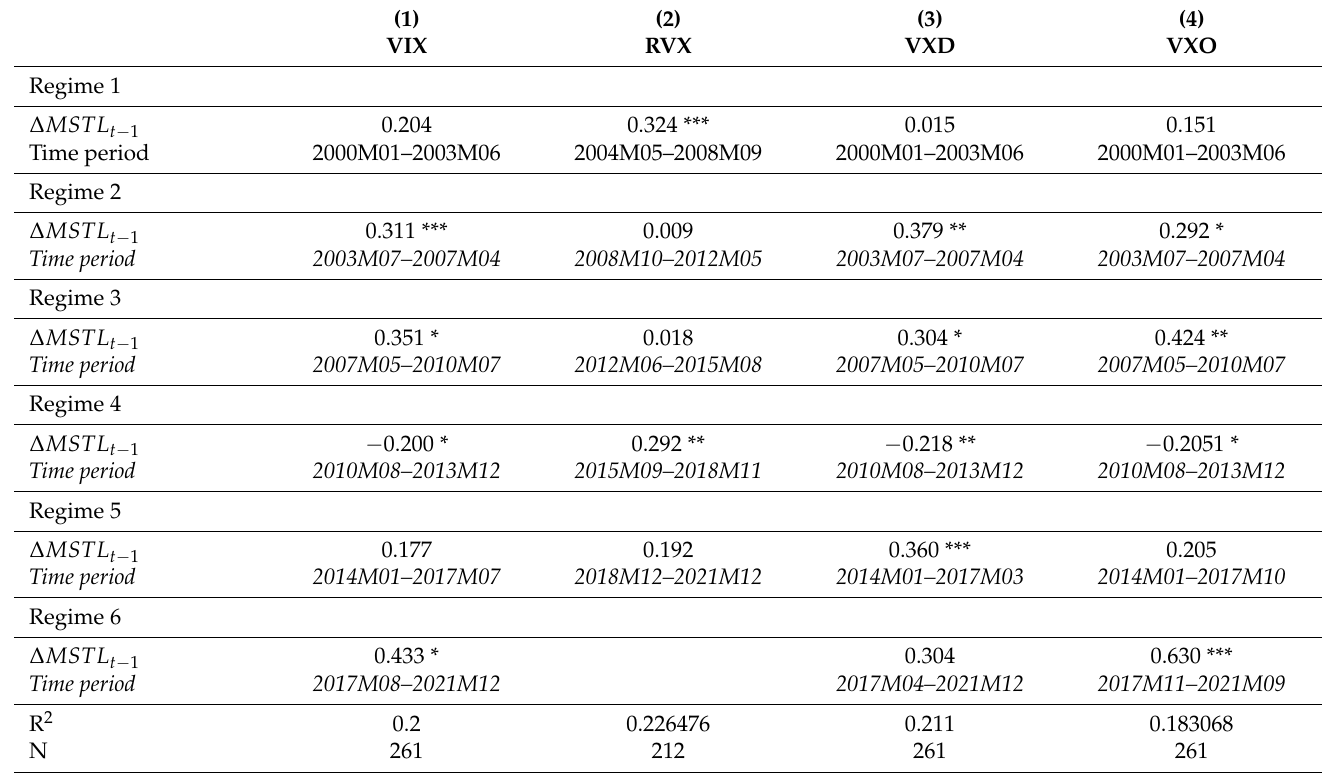
Table 3. Forecasting stock market implied volatility with financial reports tone disagreement: In- sample analysis with regime